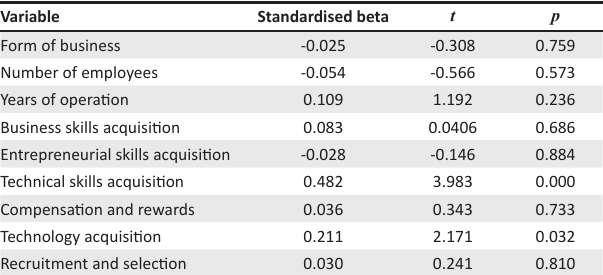
TABLE 4: Regression analysis results. Variable Standardised